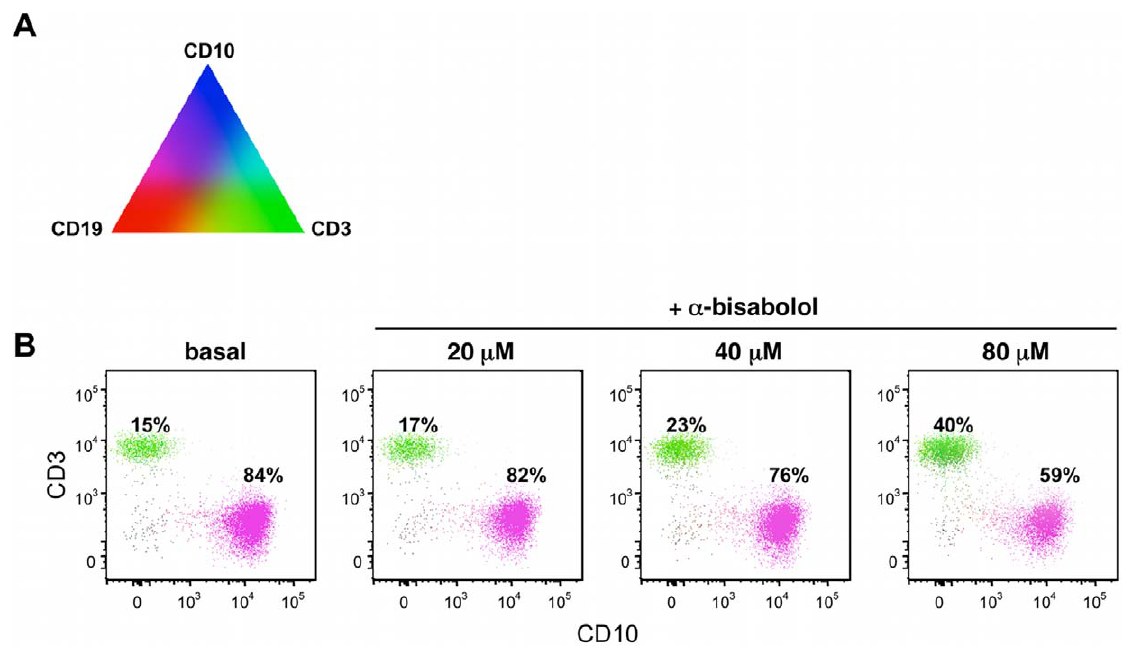
Figure 2. PolyChromatic Plot analysis of specificity of action of a -bisabolol on BCR-ABL + ALL blasts as compared to normal lymphocytes. Bone marrow mononuclear cells of a representative case of BCR-ABL + B-ALL with 15% of T-lymphocytes (patient # 08) were treated with 20, 40, 80 m M a -bisabolol for 24 hours, then immunostained with anti-CD3 FITC, anti-CD10 APC and anti-CD19 PE moAbs and analyzed by flow cytometry. (A) The triangle illustrates the different dummy colors assigned to each marker and the mixtures that results by their different amounts. (B) The bivariate PolyChromatic plots show the color mapping result: subsets of cells can be identified by the color scheme. Cells expressing only CD3 are green, those with CD19 and CD10 are magenta (i.e. blue + red). Normal CD19 + B-cells (i.e. blue) are about 1% in each plot. The comparison of the plots gives evidence that a -bisabolol induces a dose-dependent preferential depletion of blasts while preserving normal lymphocytes. doi:10.1371/journal.pone.0046674.g002 lower than the fluorescence of untreated cells (19.5 6 1.6 vs that in BCR-ABL + cells a -bisabolol deeply alters the function of 39.7 6 4.5, respectively, p , .01), thus indicating a quenching of mitochondria, by DY m dissipation and irreversible disruption of the membrane permeability. So, the apoptotic death of BCR- both cytoplasmic and mitochondrial fluorescence due to the mPTP irreversible opening (figure 6B). These data demonstrate